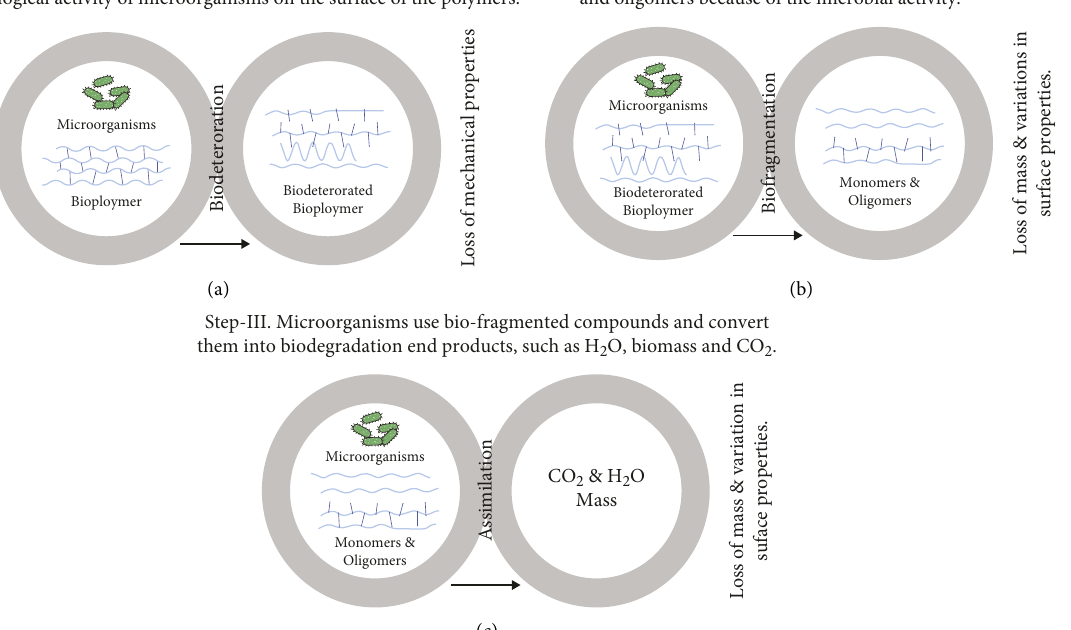
Figure 5: (a) Biodeterioration, (b) biofragmentation, and (c) assimilation are the three major steps which describe the biodegradation phenomenon of a polymer.